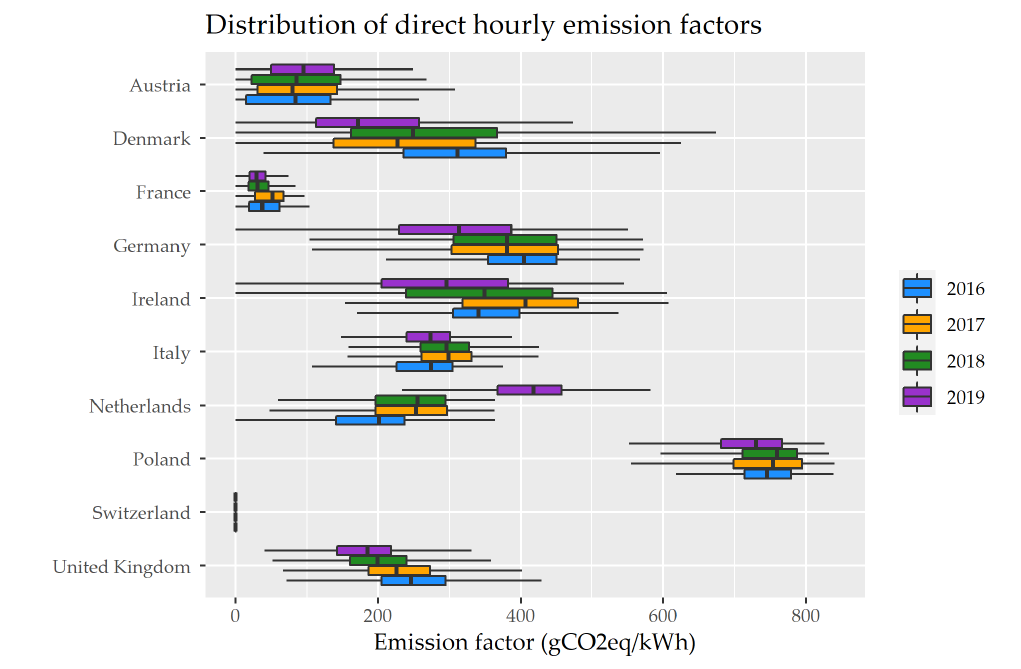
Figure 3. Comparison of direct hourly emission factors in selected European